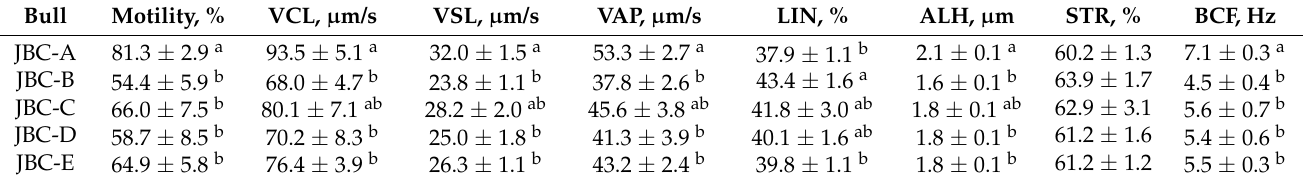
Table 2. Motility parameters of frozen–thawed 7 cm sperm from individual JBC bulls, as evaluated by SAIS.